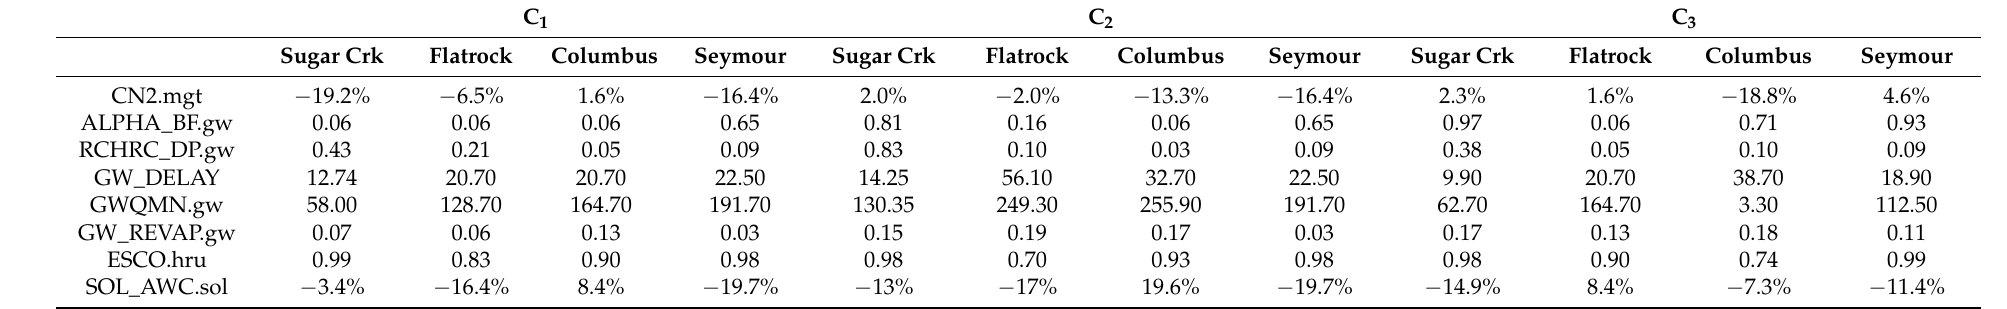
Table 2. Calibration results of the SUFI-2 algorithm for each of the three configuration periods and each of the stations’ upstream drainage areas. C 1 C 2 C 3 Sugar